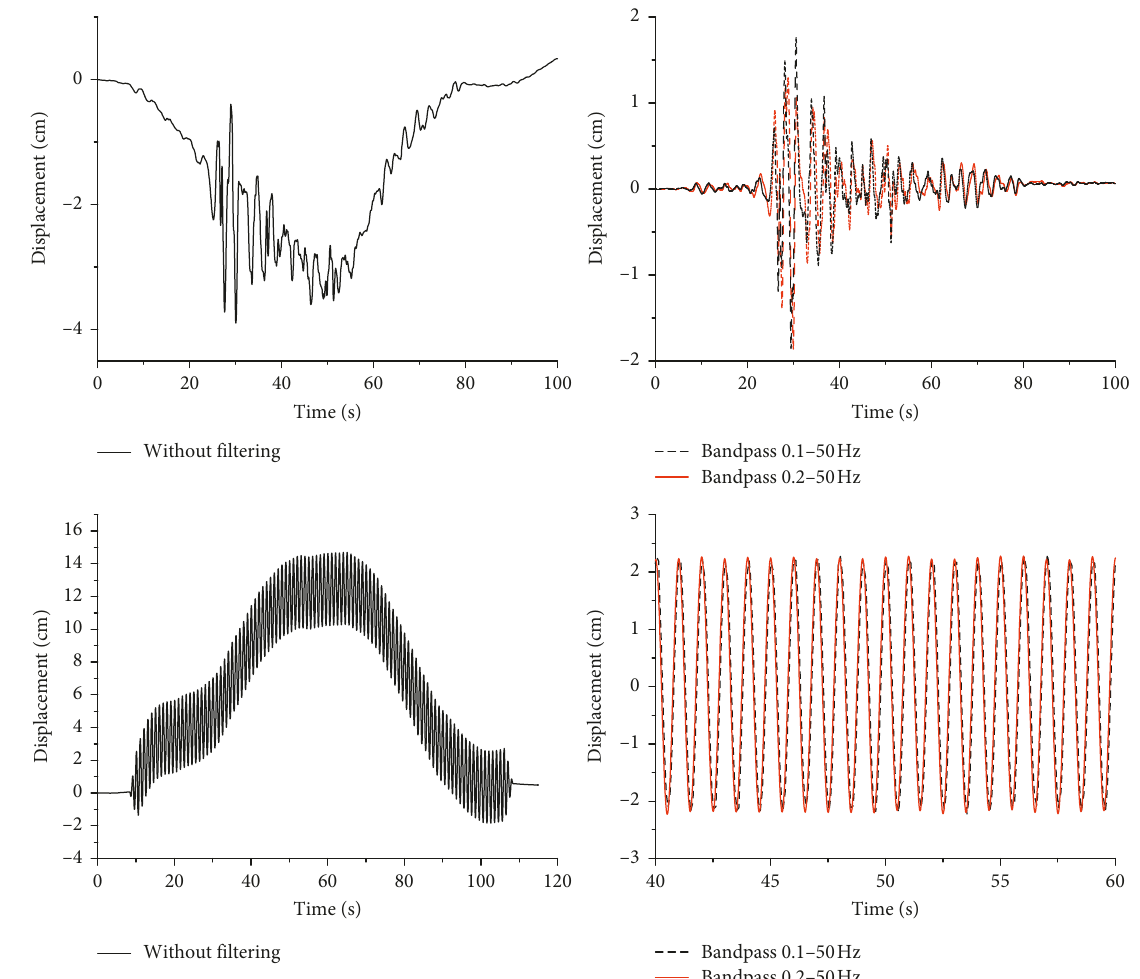
Figure 9: The ground displacement generally is adopted by the